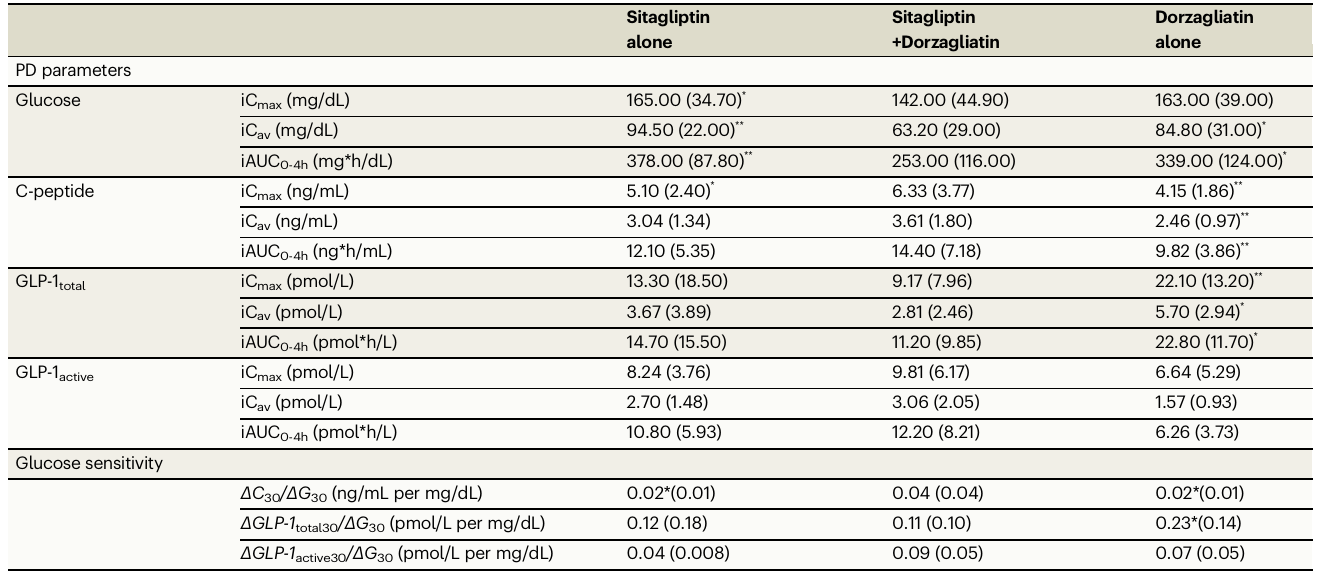
Table 3 | Pharmacodynamic parameters and surrogate estimates of glucose sensitivity during OGTT after sitagliptin, dorza- gliatin, or sitagliptin + dorzagliatin treatment Sitagliptin Sitagliptin Dorzagliatin alone +Dorzagliatin